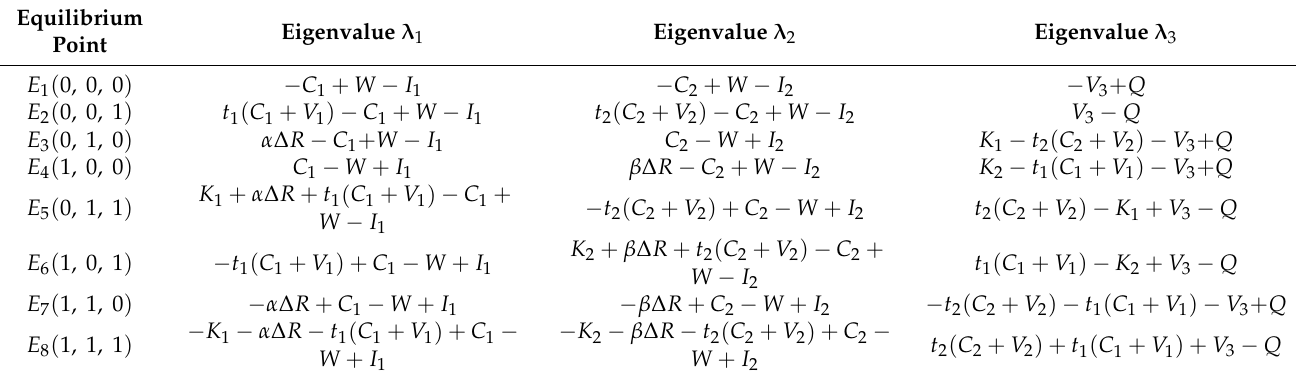
Table 3. Eigenvalues of the Jacobian matrix J .